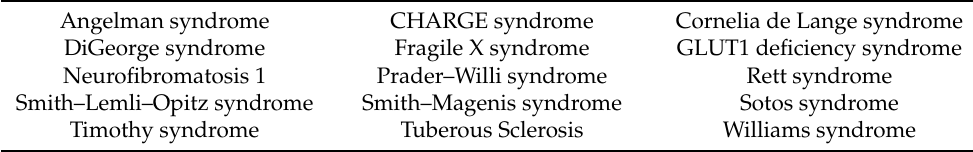
Table 2. Examples of Syndromic Autism Spectrum Disorder (ASD) with Medically Actionable Diagnoses